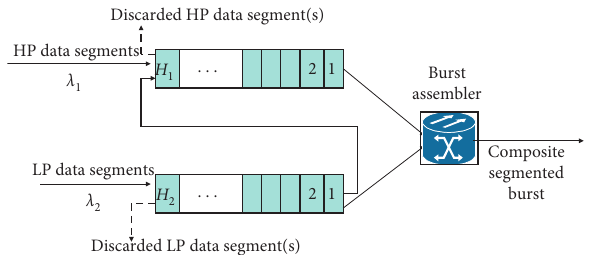
Figure 8: Dynamic segmented burst assembly approach.